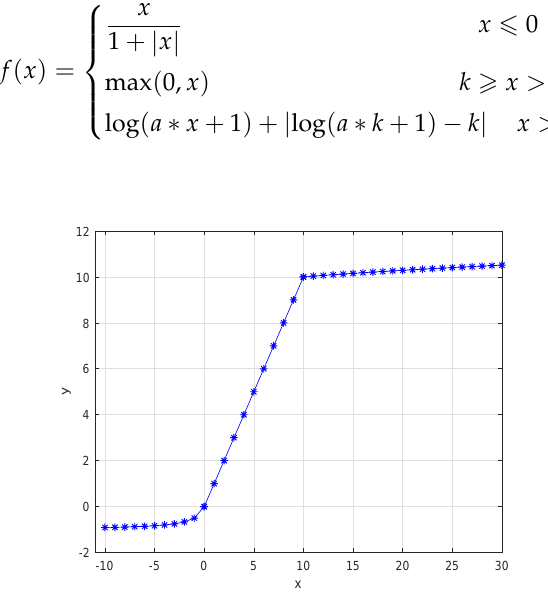
Figure 7. The new activation